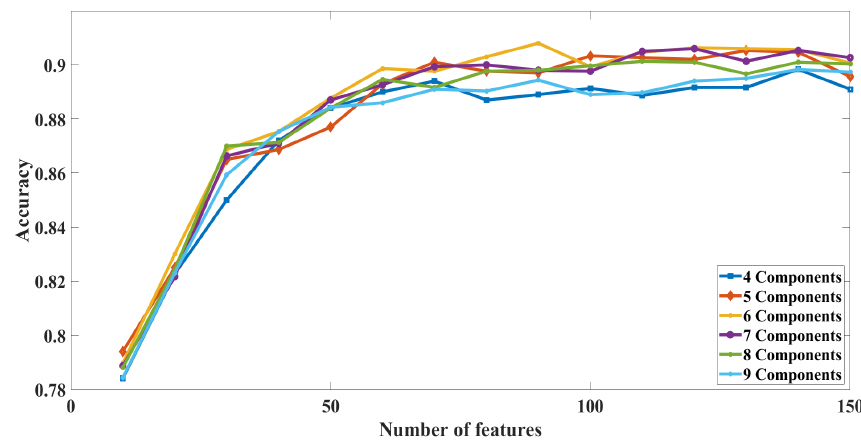
Figure 15. Effect of the number of PCA components used on the system’s